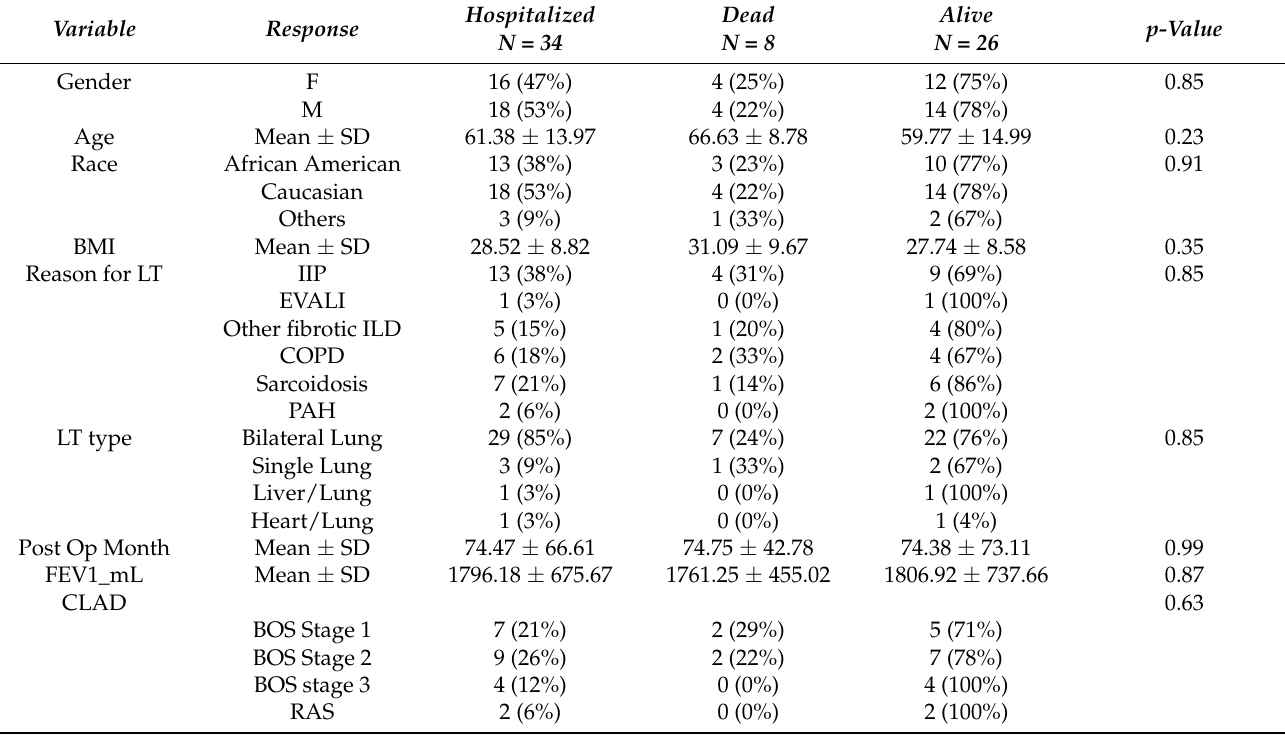
Table 2. Factors associated with mortality among hospitalized